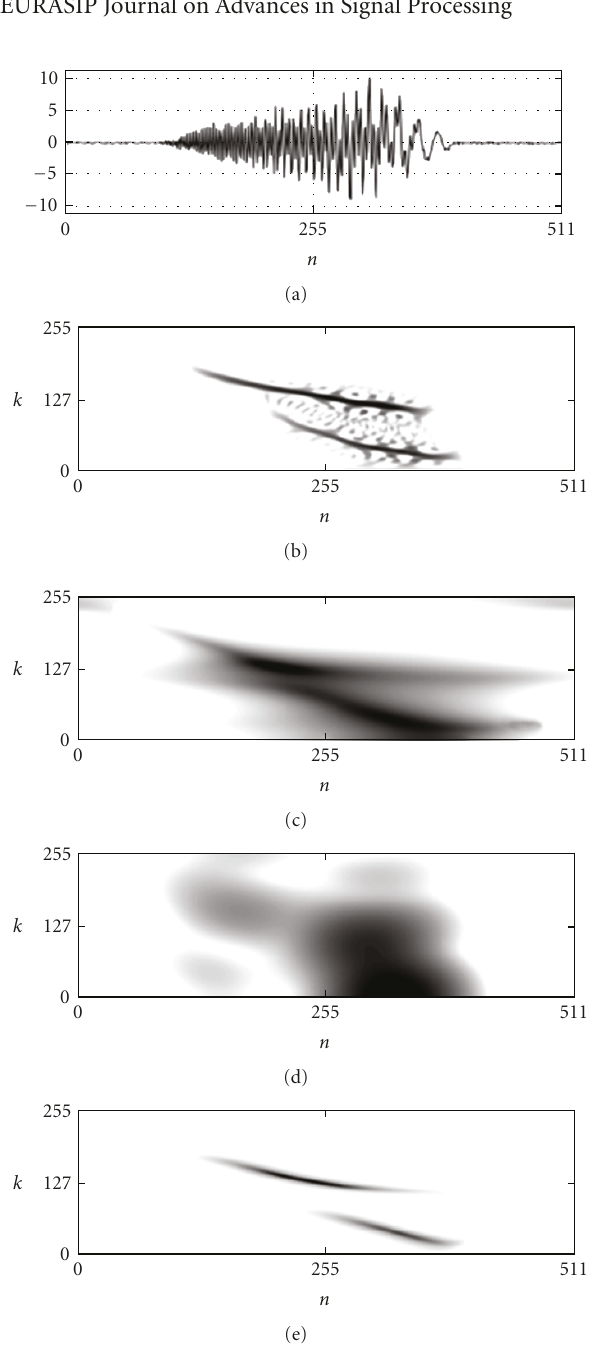
Figure 3: Time-varying parametric spectral analysis of the sum of two bat echolocation signals: (a) time-domain signal; (b) smoothed pseudo-Wigner distribution; (c) TFAR spectral estimate; (d) TFMA spectral estimate; and (e) TFARMA spectral estimate. Logarithmic gray-scale representations are used in (b)–(e) (all adopted from Jachan et al.